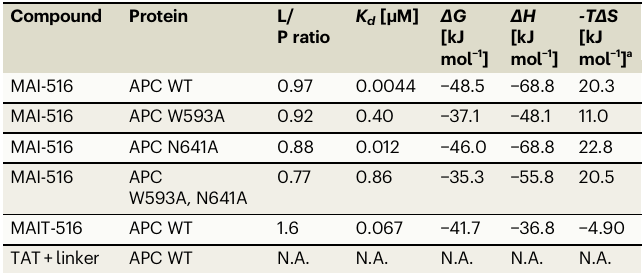
Table 6 | Thermodynamic data for MAI-516 binding to APC and mutated APC